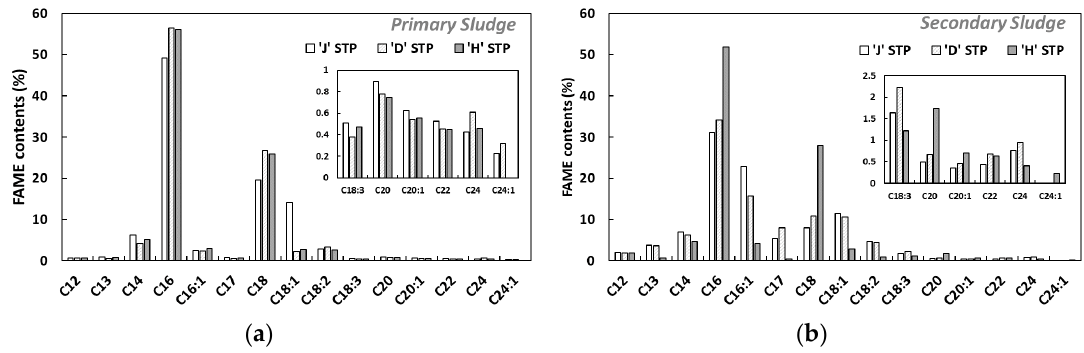
Figure 3. Fatty acid methyl ester (FAME) composition profile obtained from the in situ transesterification of ( a ) PS and ( b ) WAS for each STP.